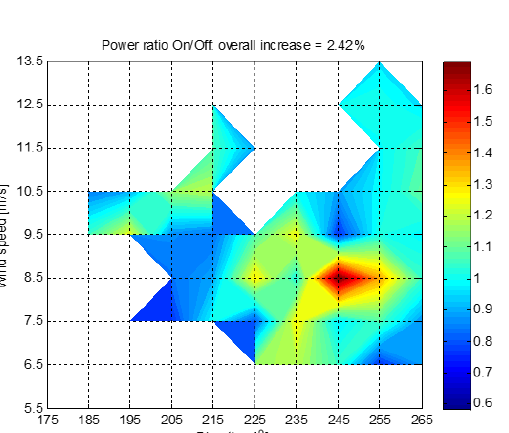
Figure 15. Field test results binned on wind speed and direction.